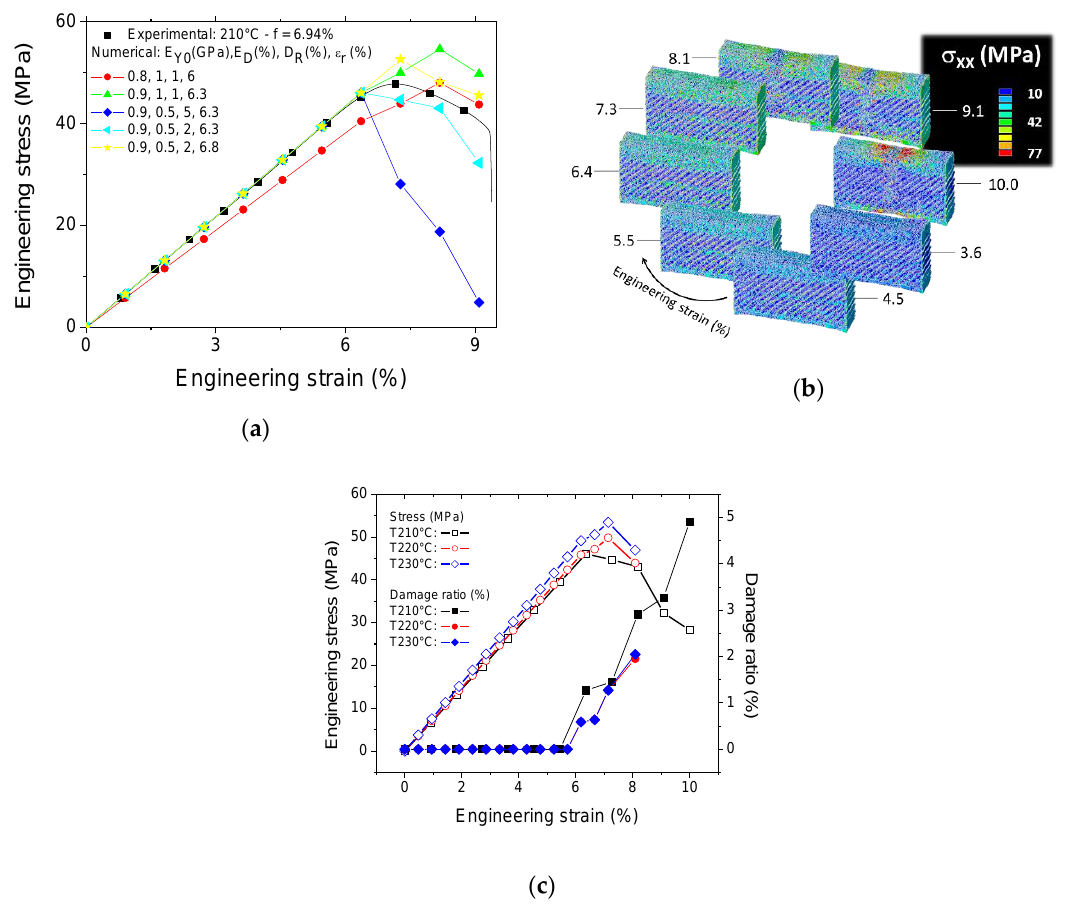
Figure 16. Damage modelling results: ( a ) Predicted tensile responses of 3D-printed PLA for various combinations of damage model parameters and a printing temperature of 210 ◦ C, ( b ) typical predicted stress component σ xx counterplot for an increasing engineering strain, and ( c ) tensile response as a function of printing temperature using linear damage model. Table 2. Predicted mechanical parameters of 3D-printed PLA as a function of printing temperature.